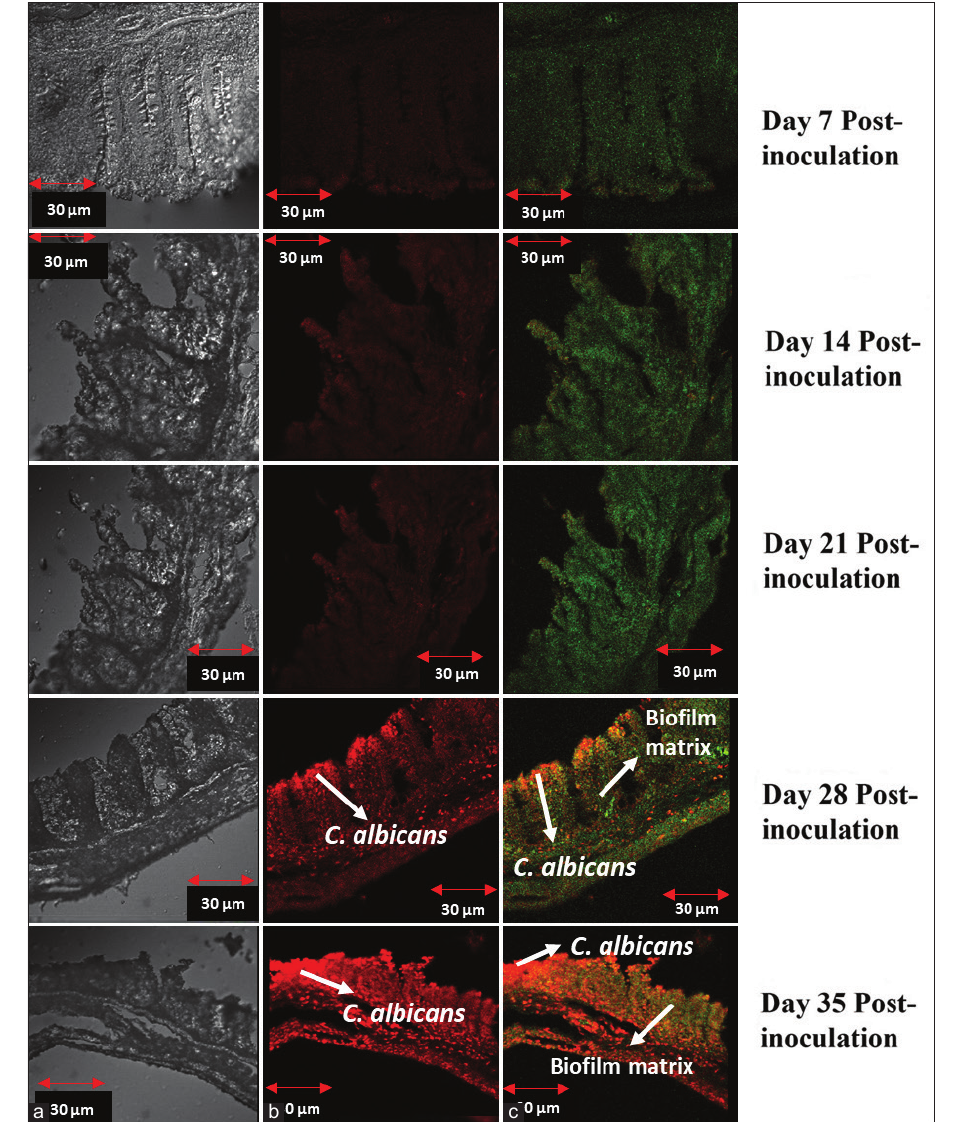
Figure-3: Candida albicans biofilm formed in the intestinal mucosa of Wistar rat s, observed with confocal laser scanning microscope using immunofluorescence method. (a) the observasion of intestine tissue with confocal laser scanning microscope (CLSM) without fluorescence staining so there are no visible color luminescence; (b) the observasion of intestine tissue stained with polyclonal anti- Candida conjugated tetramethyl rhodamine isothiocyanate (TRITC) (red) for the presence of C. albicans cells; (c) intestinal mucosa with double staining for the presence of extracellular matrix and C. albicans Con-A (green) and C. albicans cells stained by polyclonal anti- Candida conjugated TRITC